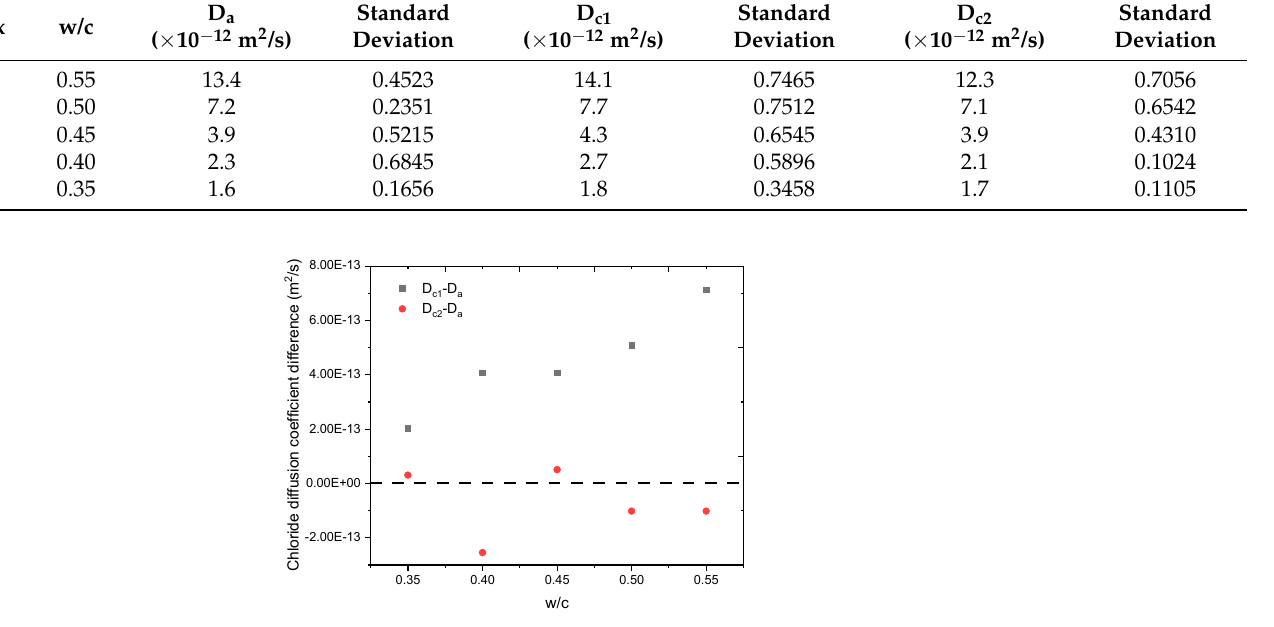
Table 5. The calculated effective chloride diffusion coefficient of all mixtures. Mix w/c